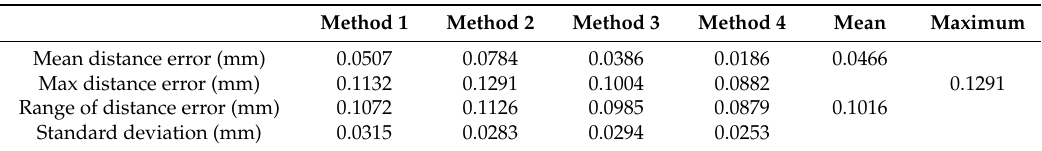
Table 6. Distance error results per virtual distances evaluation method.